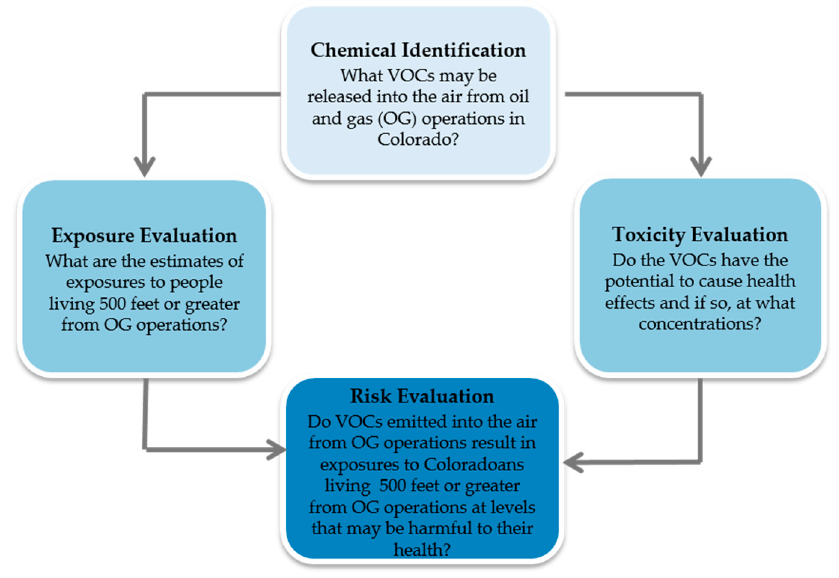
Figure 2. Four steps and associated questions that frame the scope of the screening level health risk evaluation.